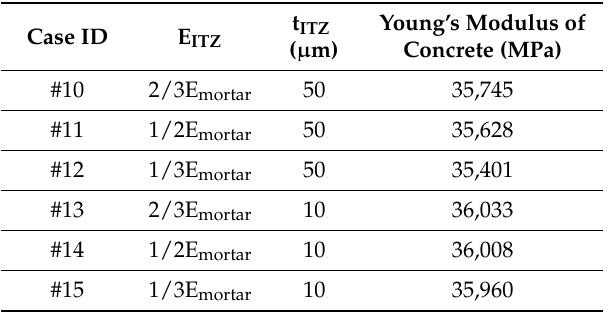
Table 3. Calculated Young’s modulus of concrete with di ff erent ITZ data. E agg = 50 GPa. Mesh: single block, p = 1. Experimental value is 36,360